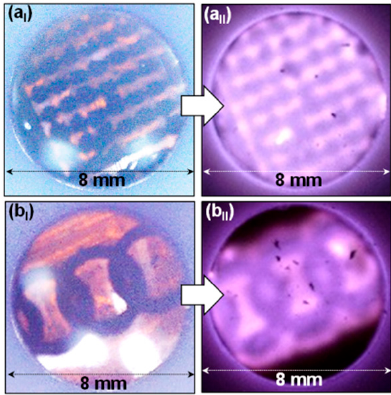
Figure 6. Patterned lines ( a I ) and circles ( b I ) of the LIGNs on polyimide substrates and ( a II ,b II ) the corresponding plasma images of the LIGN-based plasma display devices at an applied voltage of 350 V.